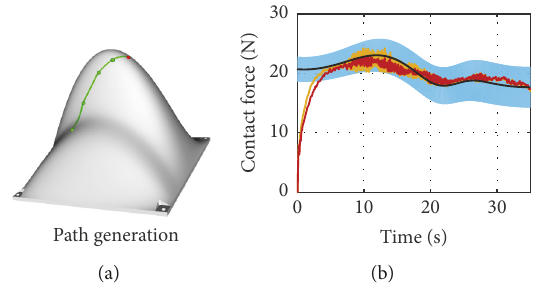
Figure 12: Trajectory generation and force tracking with adaptive hybrid force/position control. (a) Interactive trajectory generation for the surface polishing. (b) Contact force tracking using adaptive PI controller with 2 trials in different values of 𝐾 𝑓 𝑝 . The blue region is the 3 𝜎 interval of the contact force distribution and the black line is the desired force. The RMSE of the force tracking error is 1.58N for red ̂𝐹 Figure 10: Mapping policy of 𝑥 𝑝 󳨀→ . (a) GMR result for 36 groups of mapping. The colors of these lines attached to the surface ̂𝐹 refer corresponding value of contact force along with the position 𝑥 𝑝 . (b) GP regression result for the whole surface mapping from position to contact force.